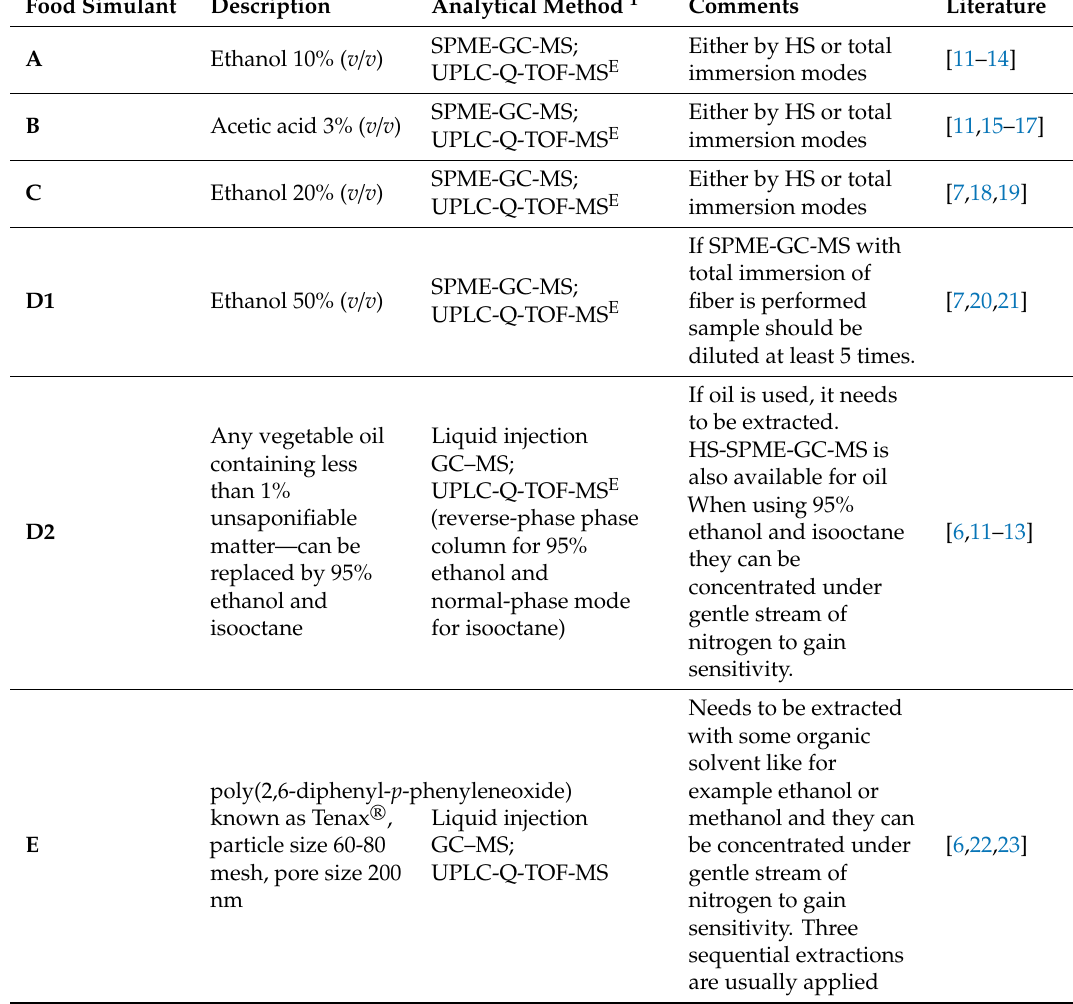
Table 1. Examples of analytical methods for di ff erent